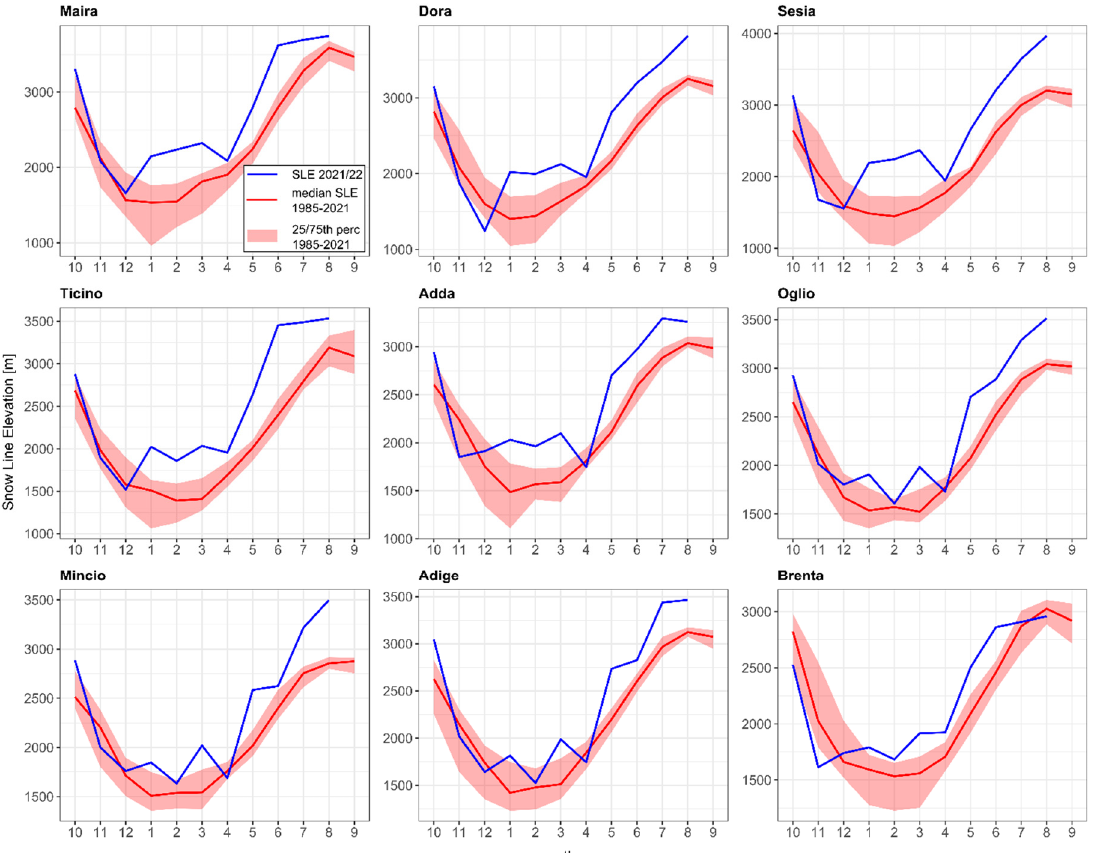
Figure 2. SLE of the hydrological year 2021/22 (blue line) in comparison to the median (red line) and 25th and 75th percentiles (red area) between 1985 and 2021 for nine Italian catchments.